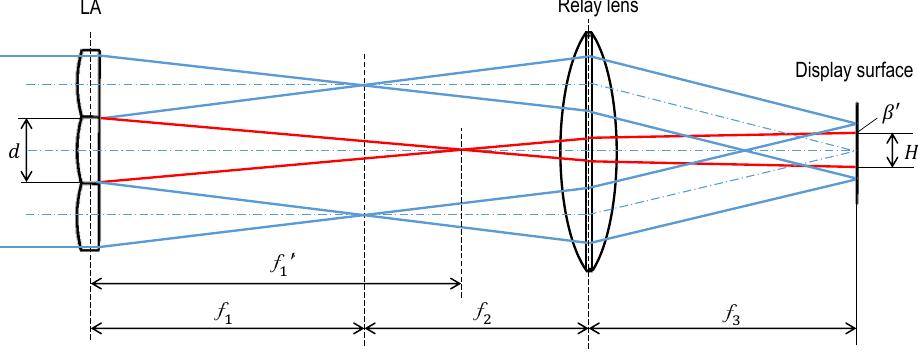
Figure 9. Principle of a focal length changed LA inhomogenizer [14].